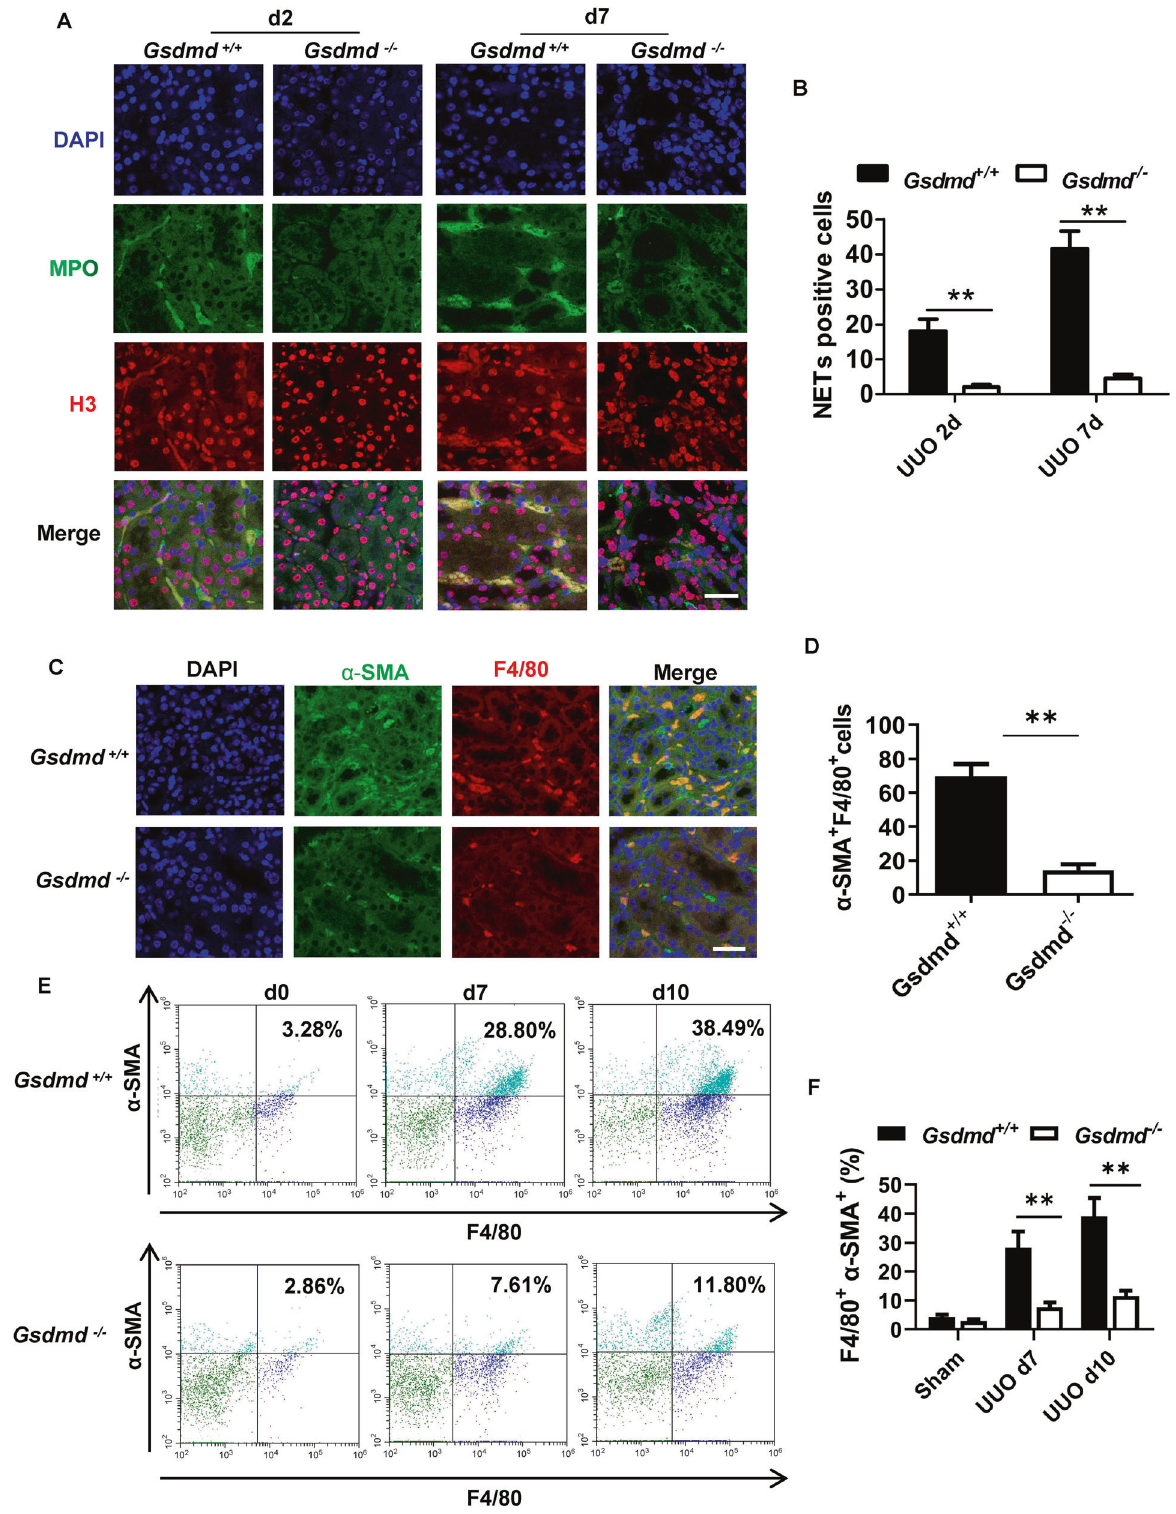
Fig. 4 Deletion of Gsdmd suppressed NETs formation and α -SMA expression in macrophages in kidney after UUO. A Representative images of immuno fl uorescence staining of kidney sections, showing the expression of Histone-H3 and MPO. Kidneys were isolated from Gsdmd + / + mice and Gsdmd − / − mice on day 2 and 7 after UUO. Scale bar: 100 μ m. B Quanti fi cation of cells undergoing NETs formation characterized by Histone-H3 and MPO double positive. n = 6. C Representative images of immuno fl uorescence staining of kidney sections, showing the coexpression of α -SMA and F4/80 in macrophage-to-myo fi broblast trasition cells on day 7 after UUO. Scale bar: 100 μ m. D Quanti fi cation of cells coexpressing α -SMA and F4/80 by immuno fl uorescence. n = 6. E Flow cytometry was used to evaluate the percentage of macrophages expressing α -SMA on day 0, 7 and 10 after UUO in the kidneys of Gsdmd + / + mice and Gsdmd − / − mice. F Quanti fi cation of the percentage of macrophages expressing α -SMA in the kidneys by fl ow cytometry analysis. n = 3. ** P < 0.01. Cell Death and Disease (2022)